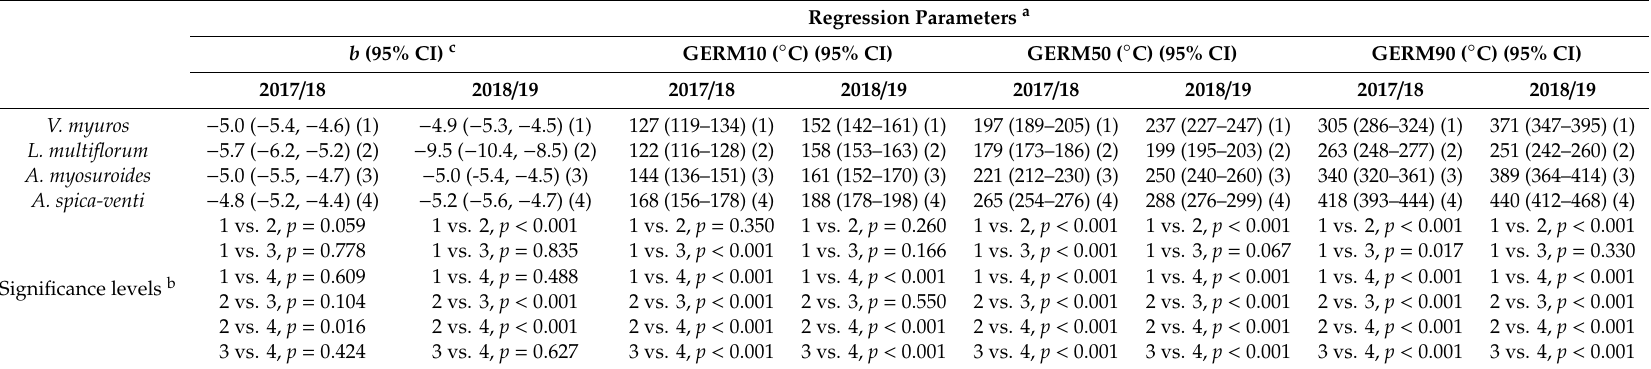
Table 1. Regression parameter estimates from log-logistic model Equation (1) for cumulative percent emergence of grass weeds in 2017 / 18 and 2018 /